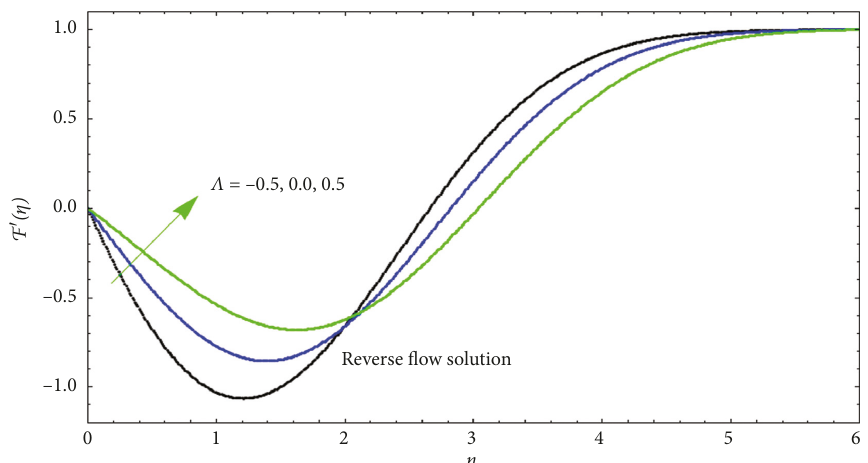
Figure 4: Dissimilarity of F ′ ( η ) being some different values of suction Λ parameter for only